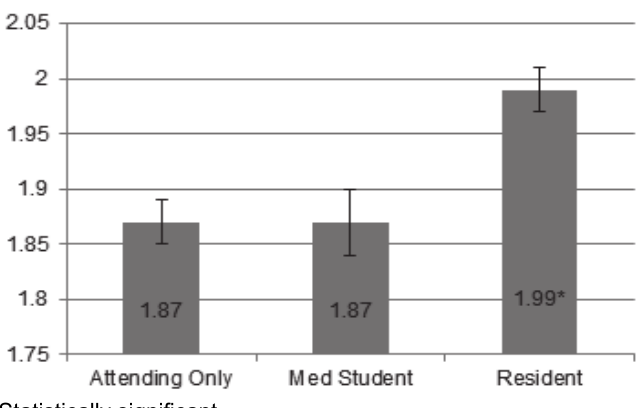
Figure 1. Attending patients per hour by team: attending, 1.87 (95% confidence interval [CI] 1.86, 1.89), attending with medi - cal student. 1.87 (95%CI 1.84, 1.90), p=0.99, and attending with resident 1.99 (95% CI 1.97, 2.00),